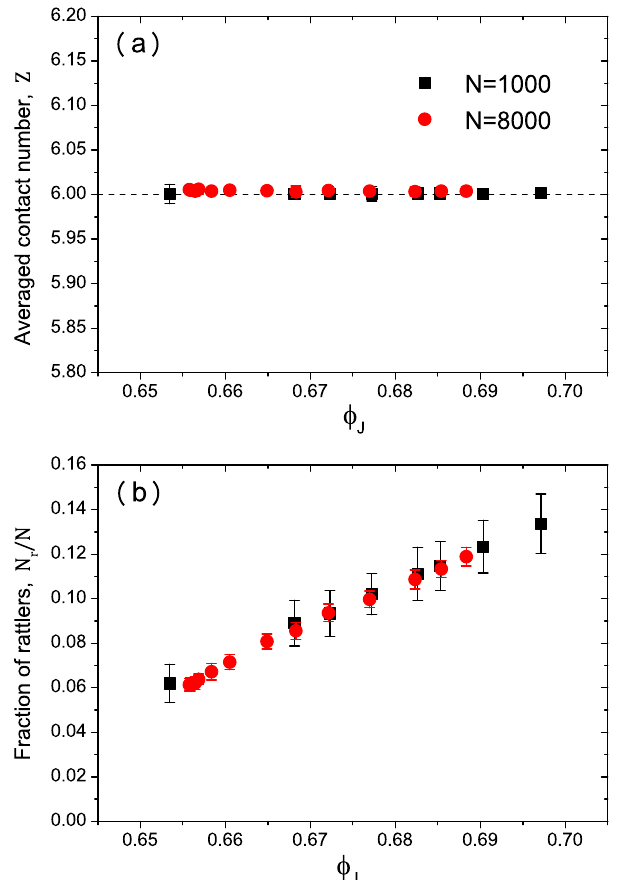
Figure 2: (a): The averaged contact number Z as a function of φ value Z = 6 along the entire J-line. (b): The fraction of rattlers, N as a function of φ J